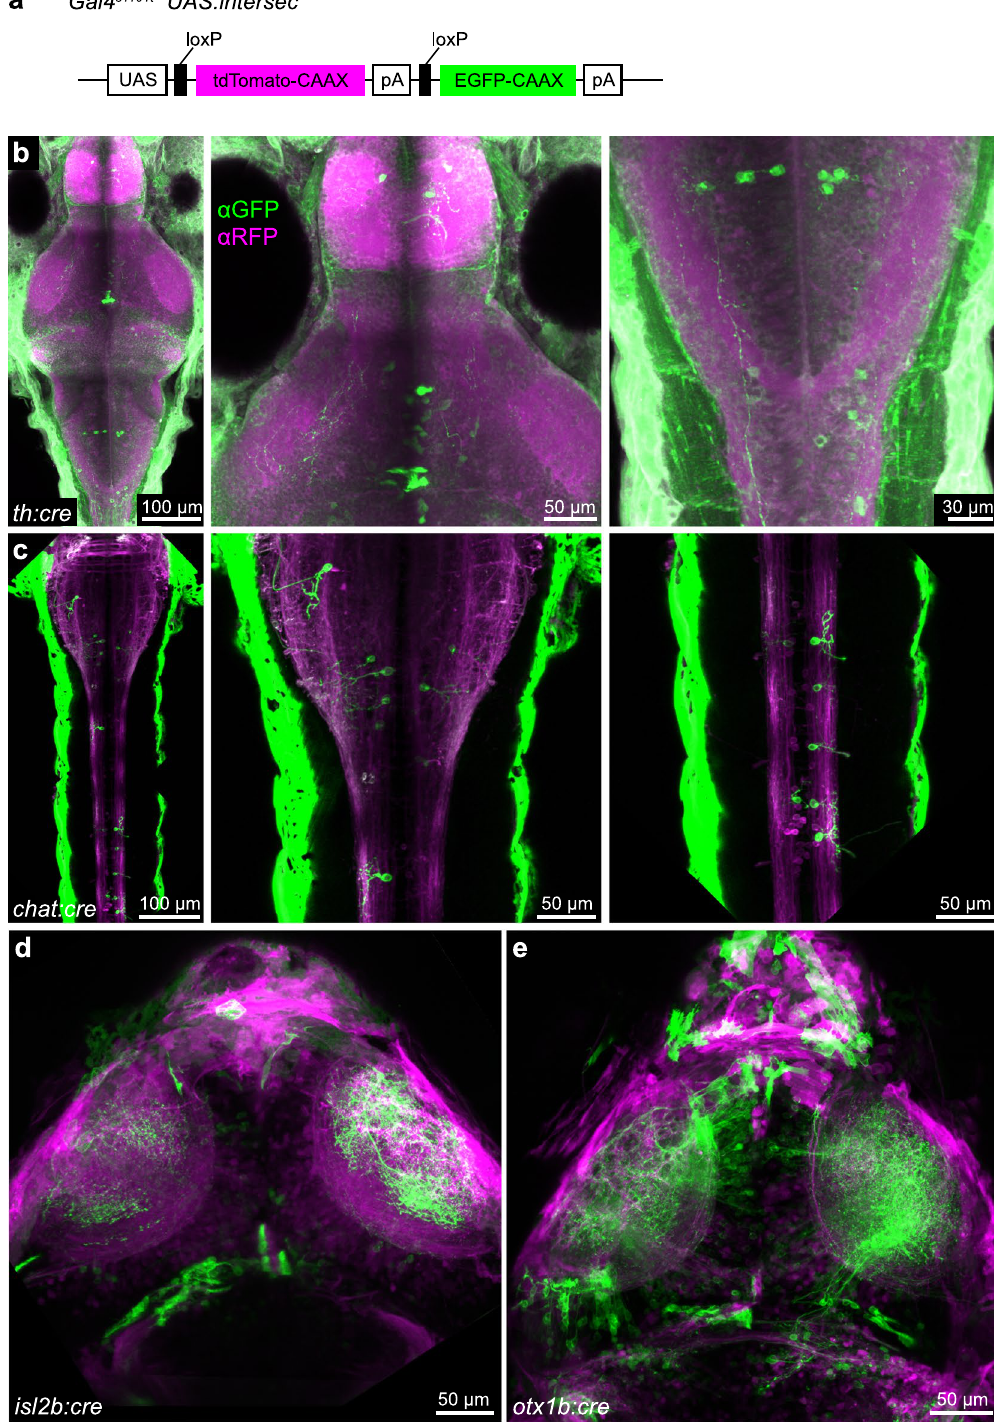
Figure 3. Cre-expressing BAC constructs allow intersectional genetics. ( a ) UAS:intersec construct for intersectional genetic approach. A pan-neuronal Gal4 line ( Gal4s1101t ) was used in this figure. ( b ) Antibody staining against GFP and RFP reveals highly variegated, transgenic expression of th:cre stable transgenic line. ( c – e ) Live imaging showing transient expression of chat:cre ( c ), isl2b:cre ( d ) and otx1b:cre ( e